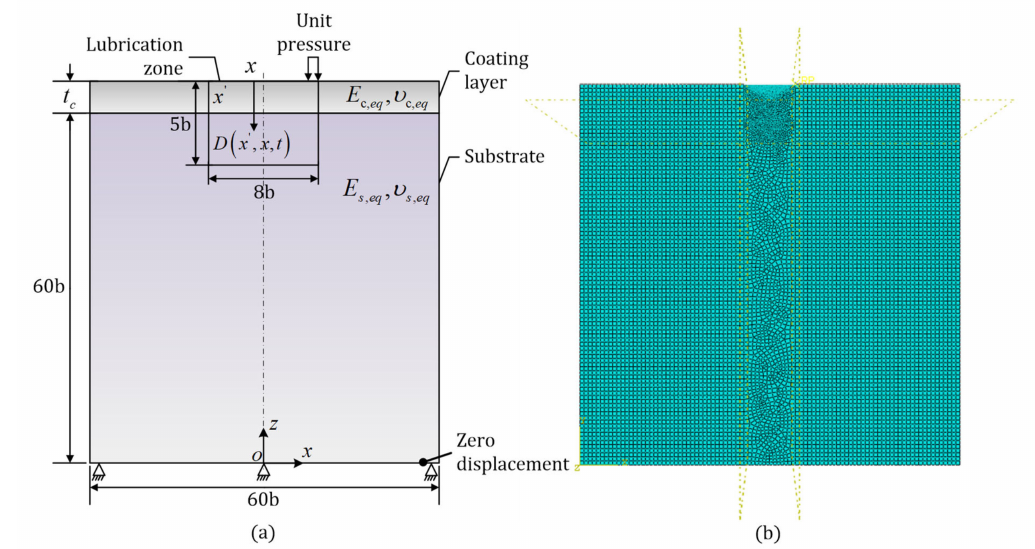
Figure 3. The elastic deformation calculation: ( a ) the computation domain and boundary conditions and ( b ) the FEM model in